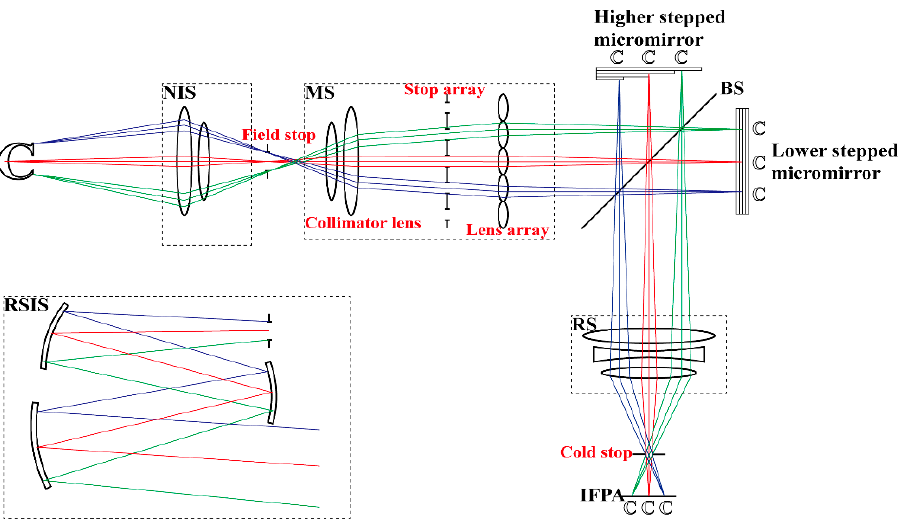
Figure 3. The initial layout of the optical design for the SIIFTS. NIS, RSIS, MS and RS are the sub ‐ systems to be designed in this paper.